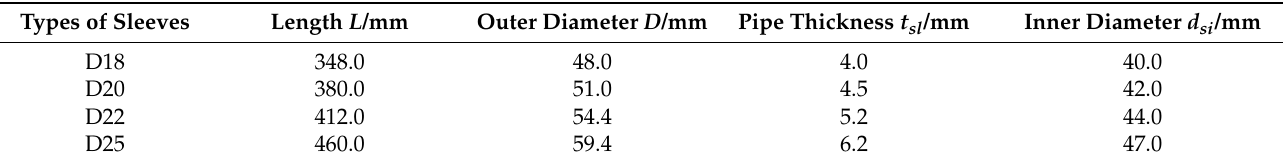
Table 1. The dimensions of the